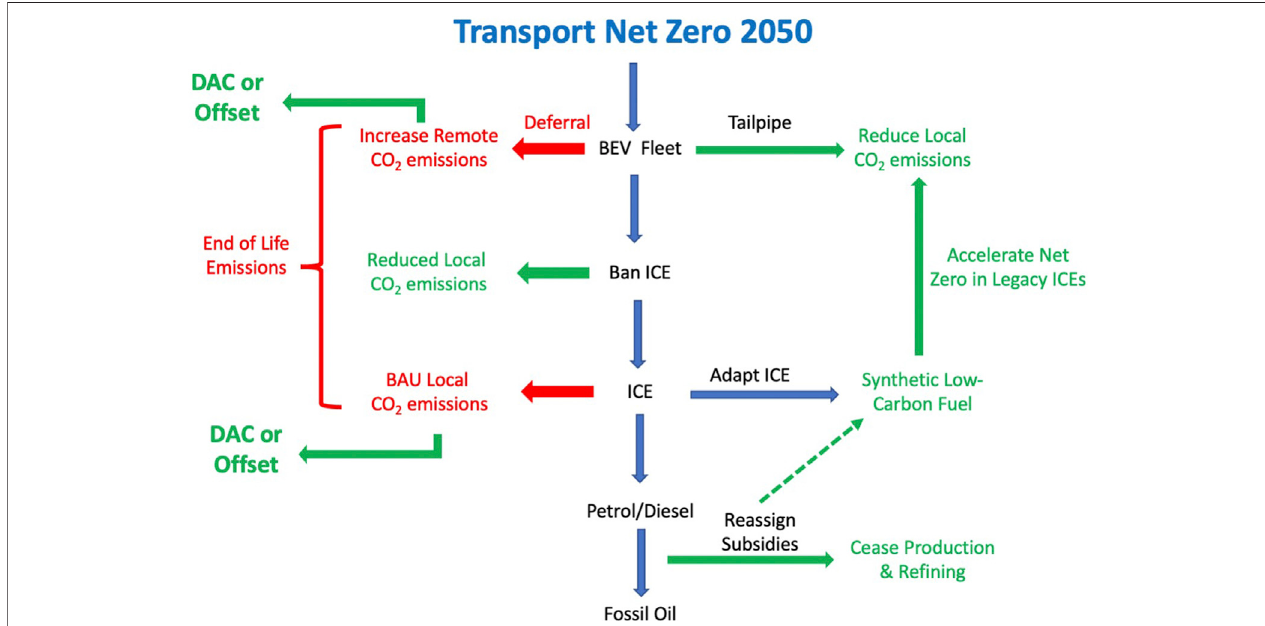
FIGURE 1 | Theory-of-change approach to accelerated transport